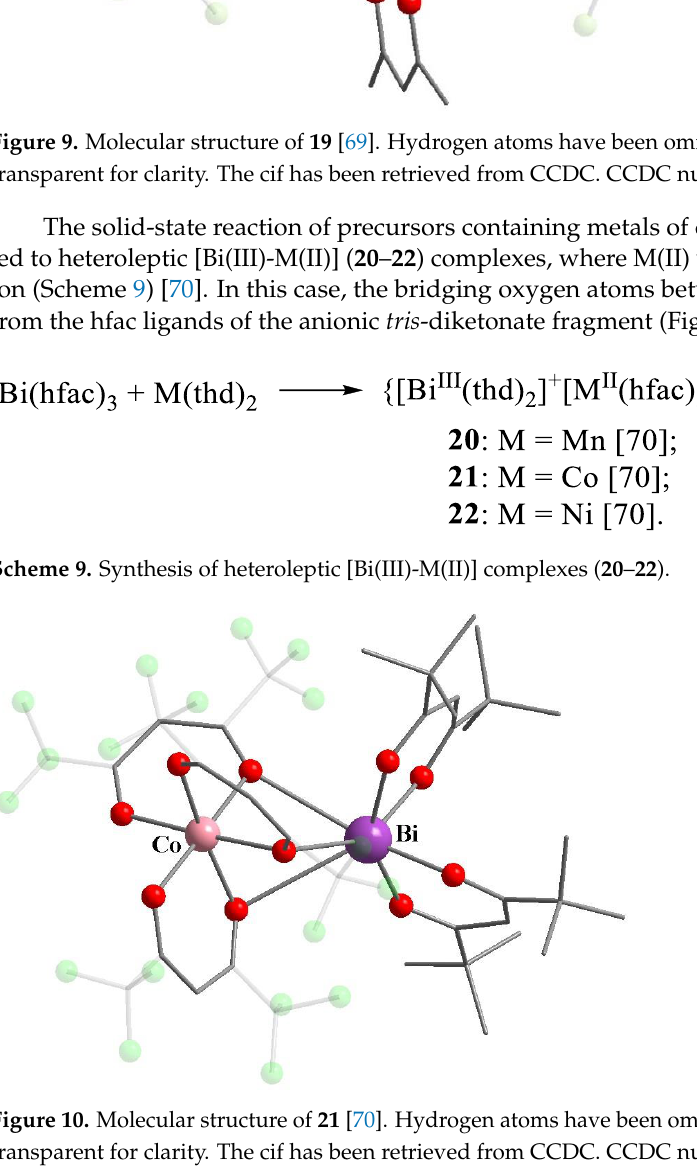
Figure 10. Molecular structure of 21 [70]. Hydrogen atoms have been omitted, CF 3 groups of hfac are transparent for clarity. The cif has been retrieved from CCDC. CCDC number is 1475305. Dikarev et al. described the first example of the heterometallic [Na-Cu] complex ( 22 ) resulting from two different fluorinated β -diketonates [64]. The reaction of unsolvated [Cu( L 14 )] and Na(hfac) gave a heterometallic β -diketonate [Na 2 Cu 2 (pfbm) 4 (hfac) 2 ] ( 22